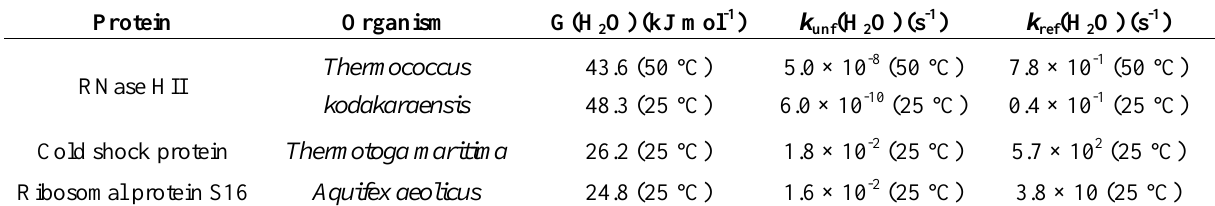
Table 1. Thermodynamic and kinetic parameters characterizing the stability and refolding/unfolding of proteins from